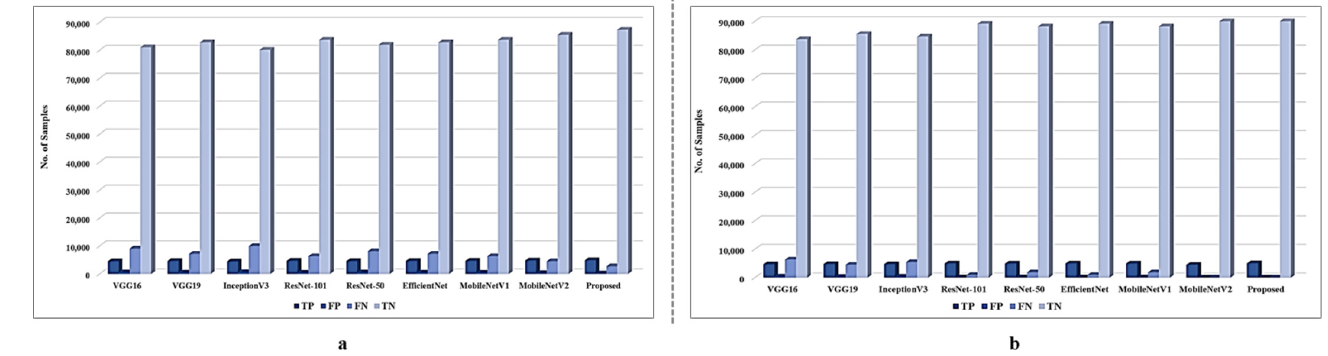
Figure 4. The detailed performance of each model in terms of TP, TN, FP, and FN over RMFR where ( a )—original dataset, ( b )—balanced dataset. Table 5. The detailed comparative analysis of different models for face mask detection.